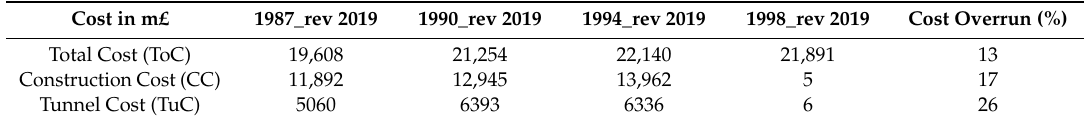
Figure 8. Cost overruns and figures revised in 2019, where TuC: Tunnel Cost, CC: Construction Cost and ToC: Total Cost. Table 7. Cost overrun adjusted to recent (2019) price